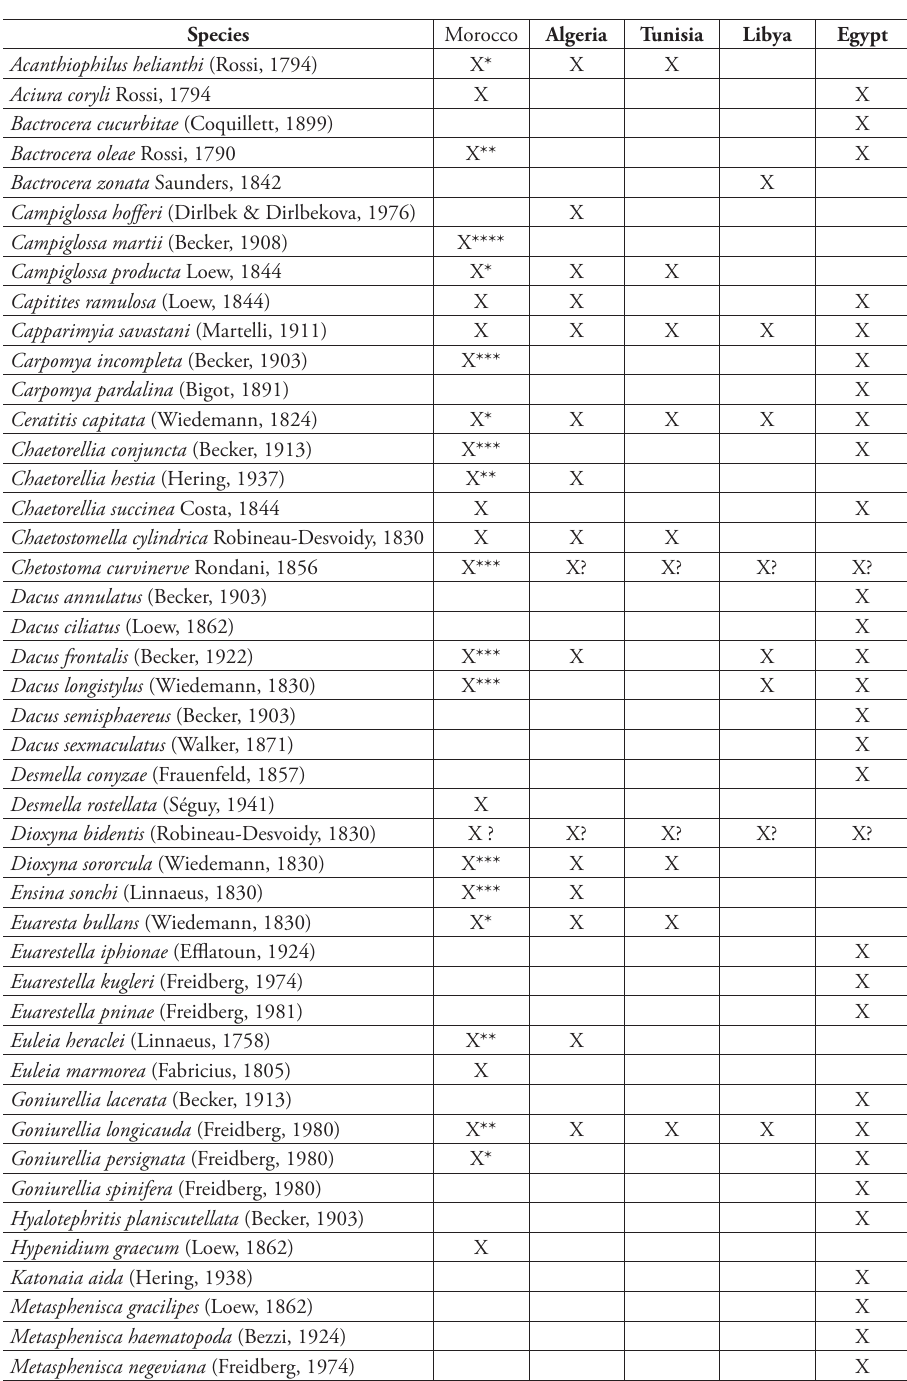
Table 1. Species (in alphabetical order) of Tephritidae known from North Africa. Species Morocco